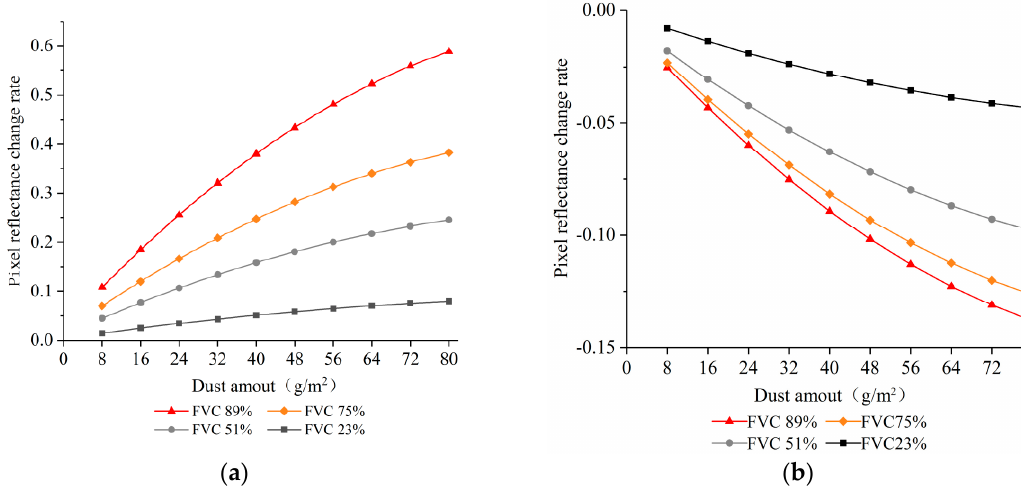
Figure 9. Spectral change rates corresponding to different FVCs under dust retention conditions ( a ) is red band (626 nm), and ( b ) is NIR band (840 nm)).